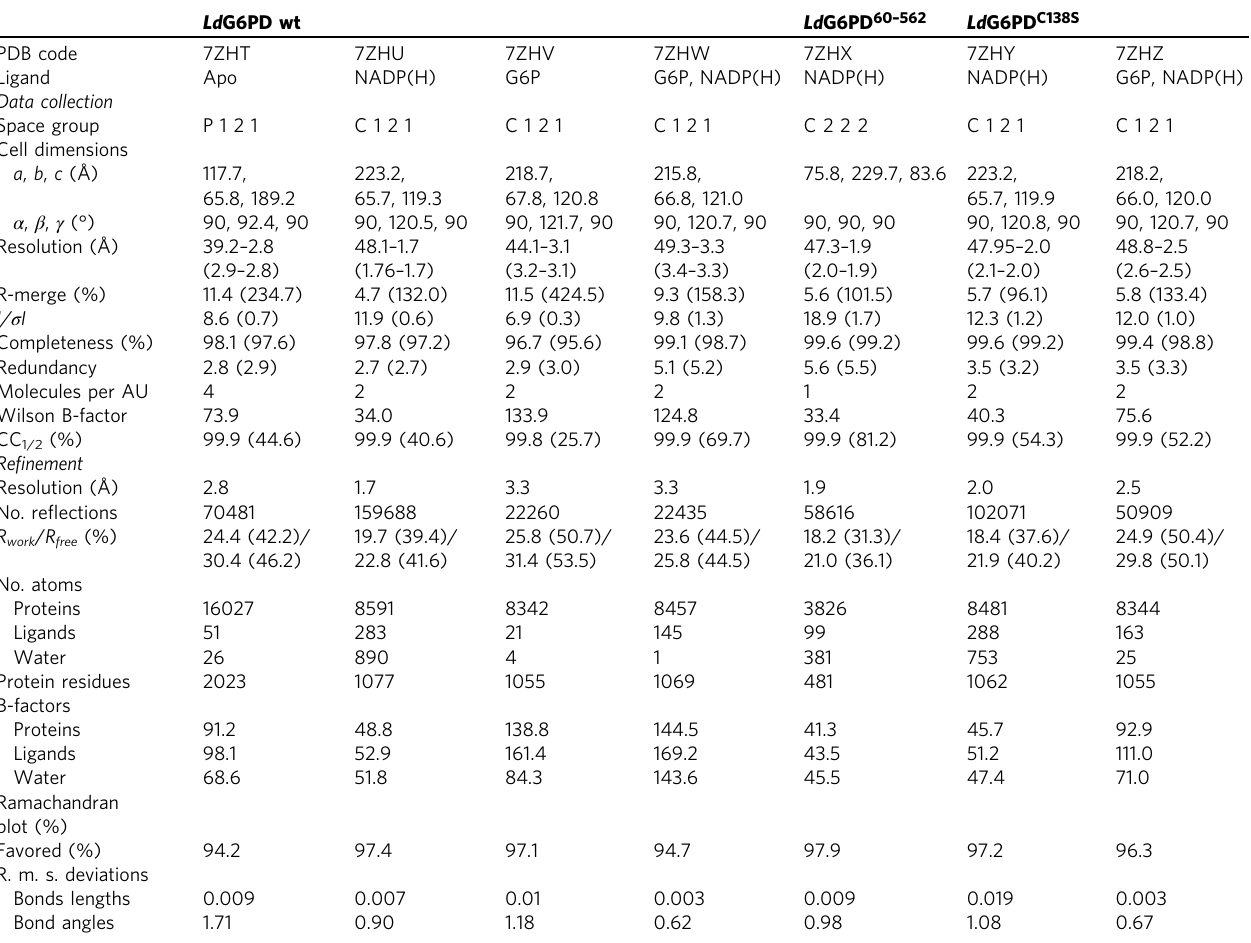
Values in parentheses are for highest-resolution